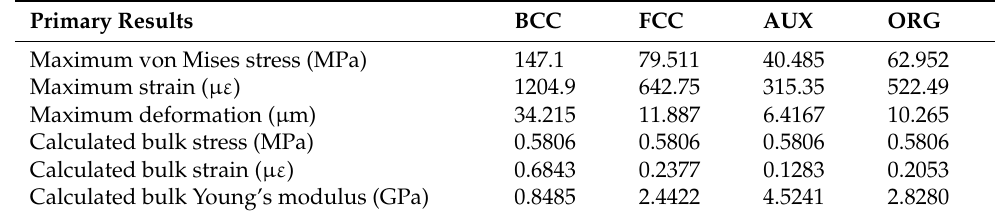
Table 7. Primary results of FEA on lattices, including calculations for bulk stress, strain, and